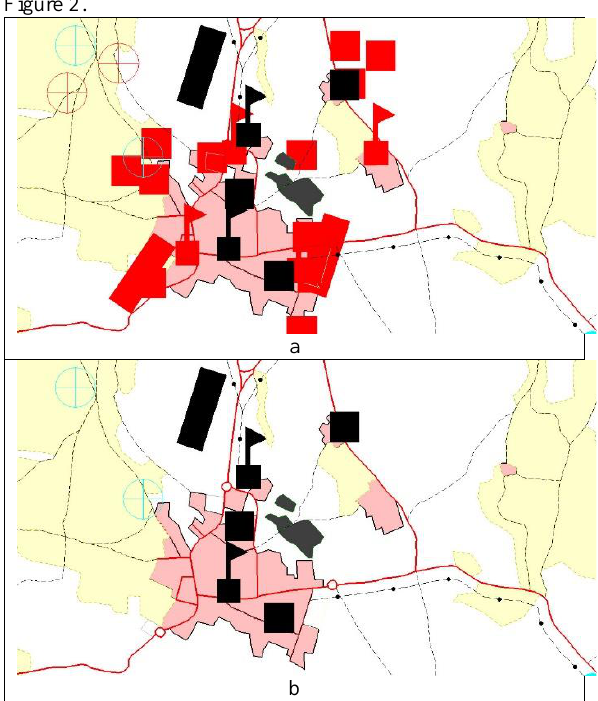
Figure 2. a: selected points are shown, b: deleted selected points and reserved one